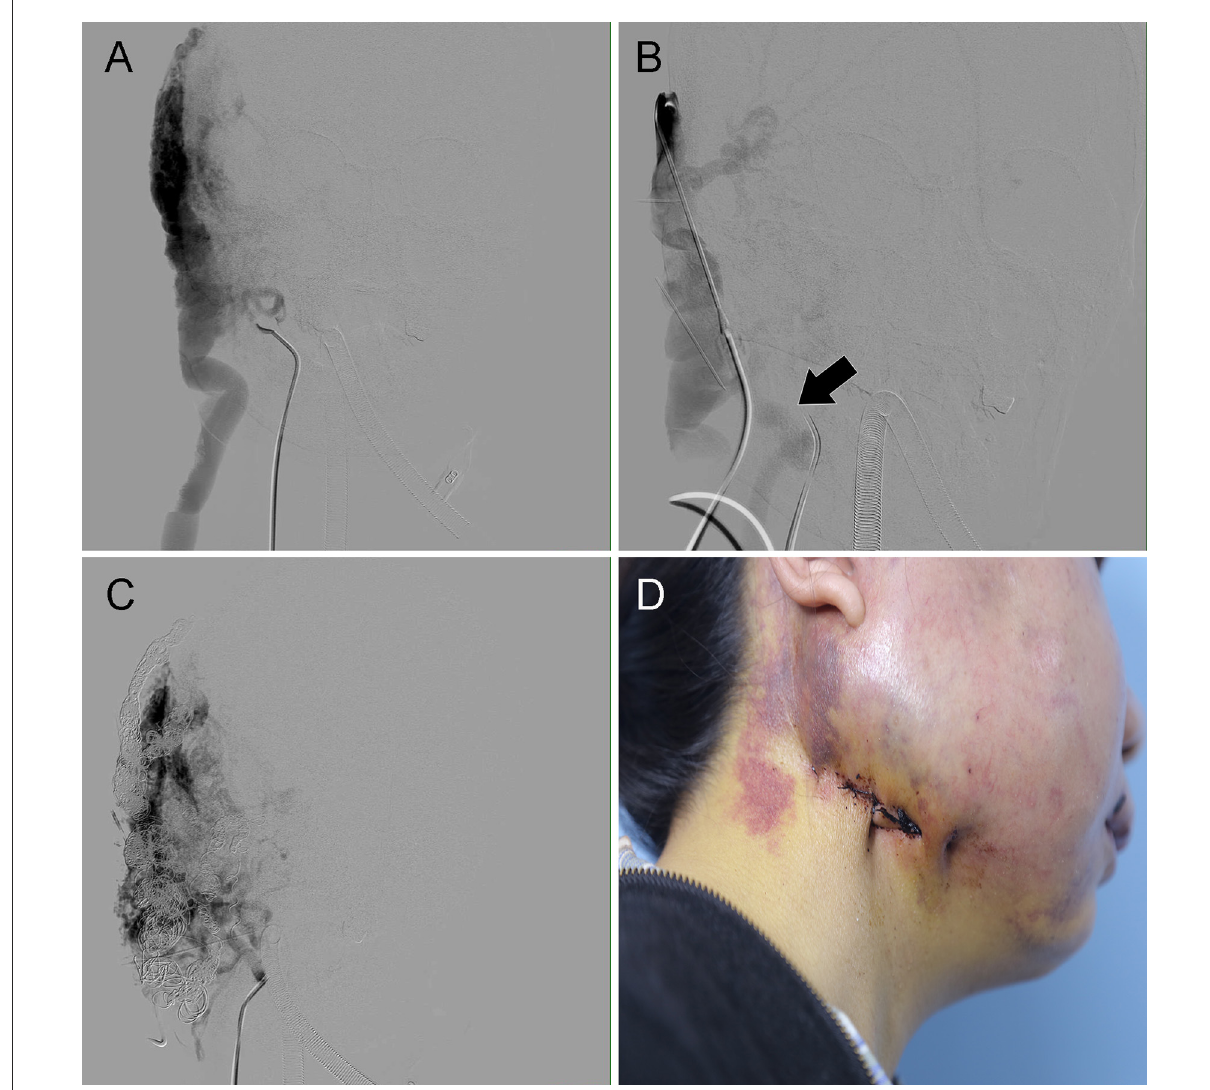
FIGURE1 Case 4 with the complaint of exertional palpitation and progressive breathlessness for 1 year. An HOCF patient with right neck arteriovenous malformations (AVMs). (A) Anteroposterior angiogram shows the location of the dilated RDDOV in the venous phase. (B) Venography through an 18-gauge needle shows the RDDOV becoming narrow after the RDDOV was sutured with a 3-0 absorbable suture (black arrow). (C) Anteroposterior angiogram shows that the RDDOV was embolized by the coils. HOCF, high-output heart failure. There is still residual AVM that would be considered in the > 99% occlusion category. (D) Photograph shows the location of the RDDOV